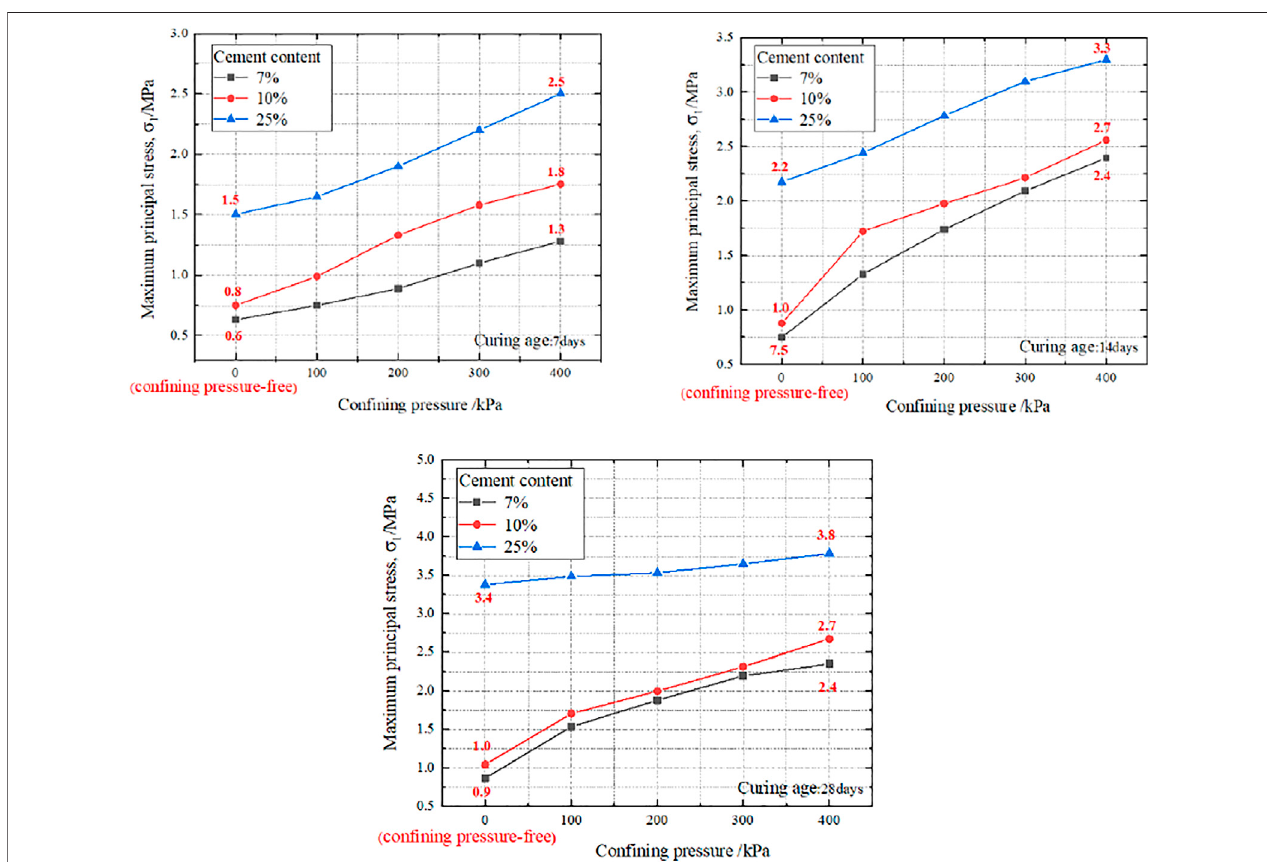
FIGURE 9 | Relation curve between maximum principal stress and con fi ning